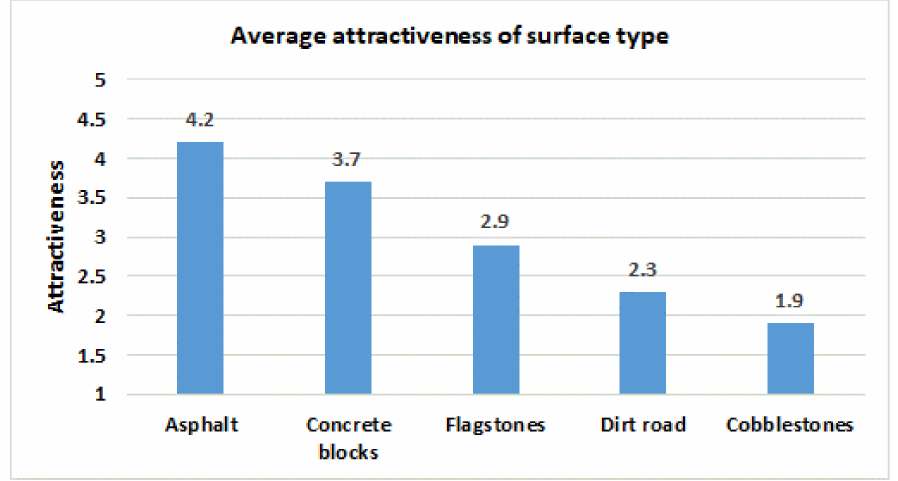
Figure 5. Attractiveness of the bicycle route to the user in terms of the route surface